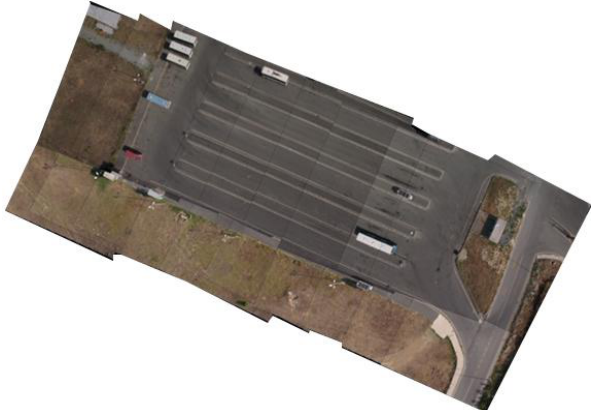
Figure 8. The mosaic image of the test